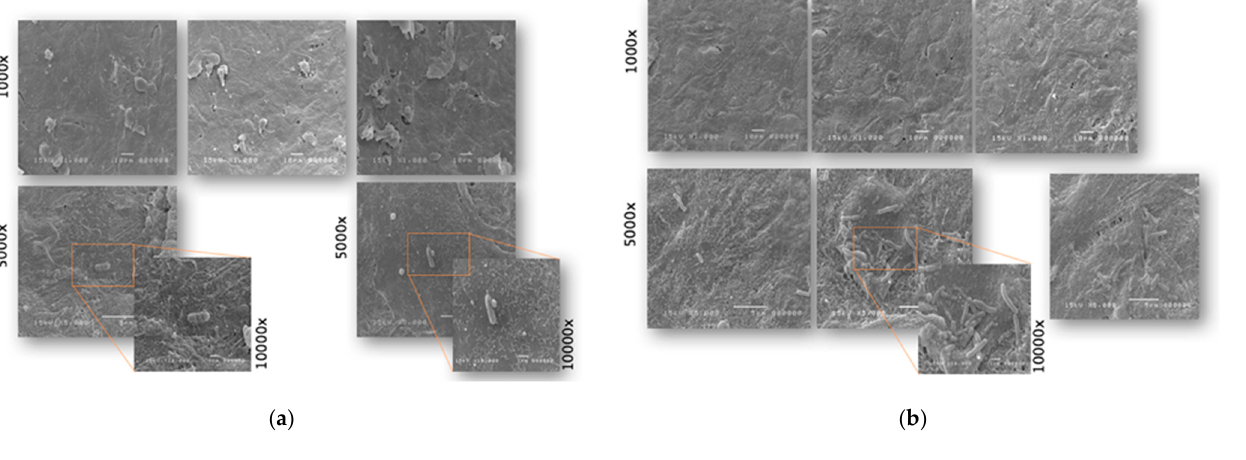
Figure 1. Representative SEM images of HBE tissue ( a ) colonized by E. coli (control) and ( b ) pretreated with L. rhamnosus LRH020. SEM image magnifications are reported near the figures.